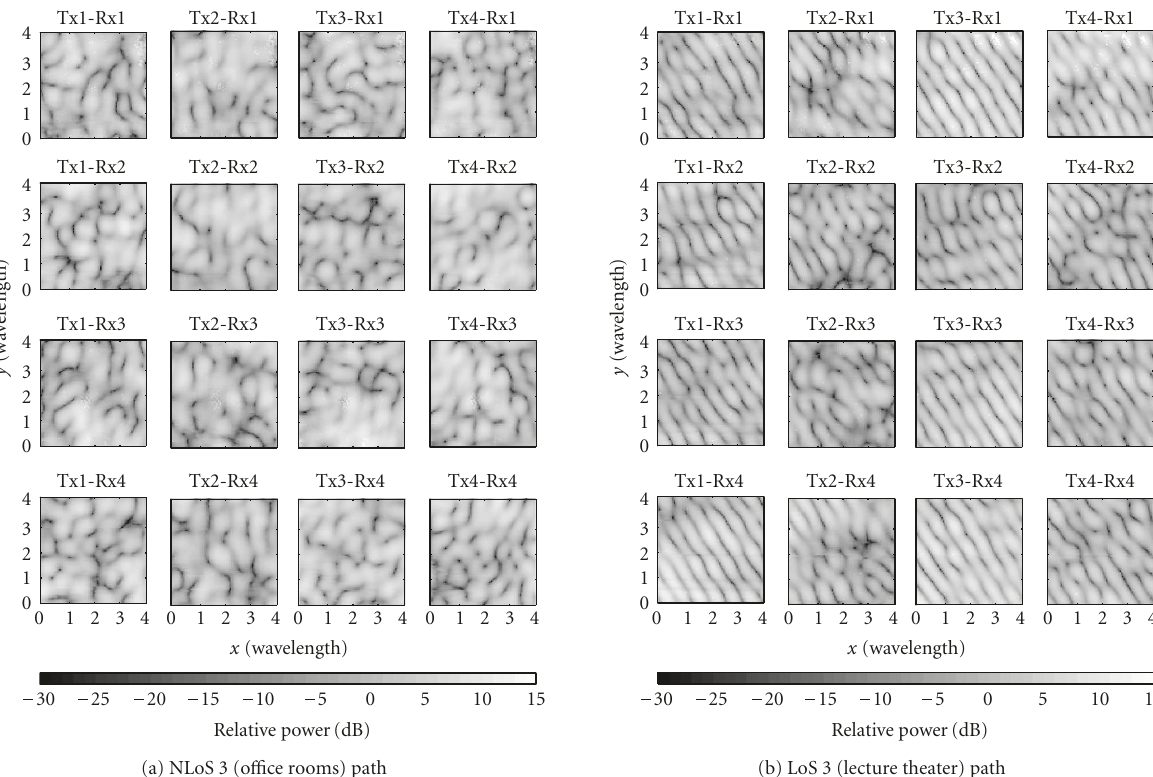
Figure 4: Examples of measured MIMO subchannel fading